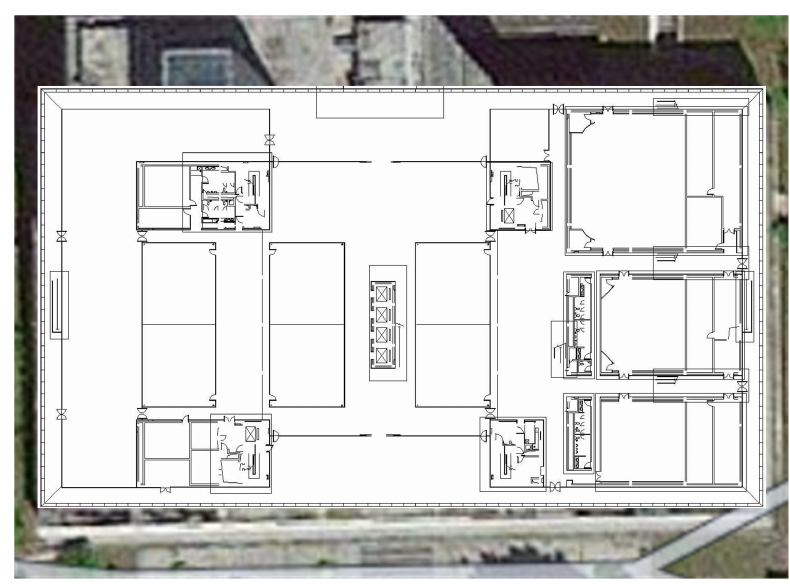
Figure 5. Layout of the study